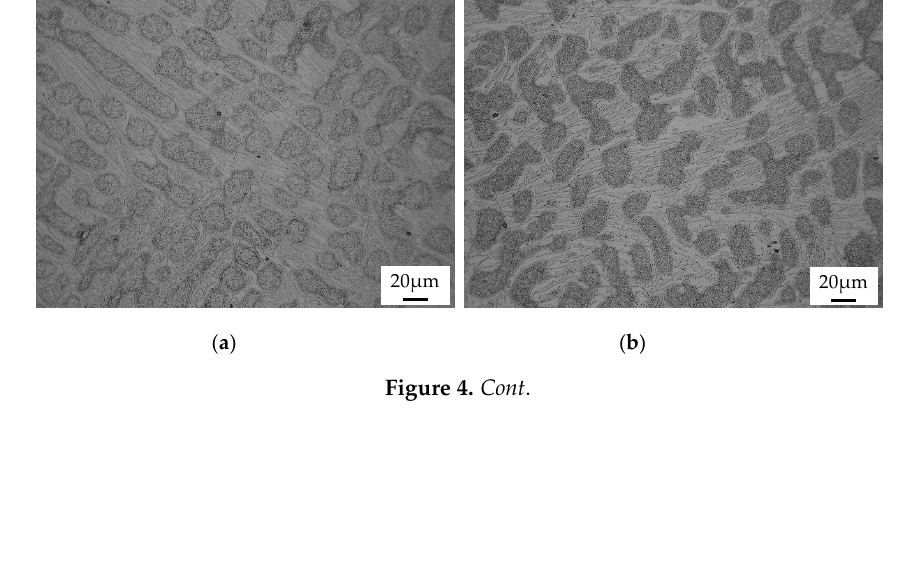
Figure 3. SEM micrographs of the as-cast alloys showing little or no precipitation within dendrite: ( a ) 2124; ( b ) 2127; ( c ) 2427; ( d ) 2827.